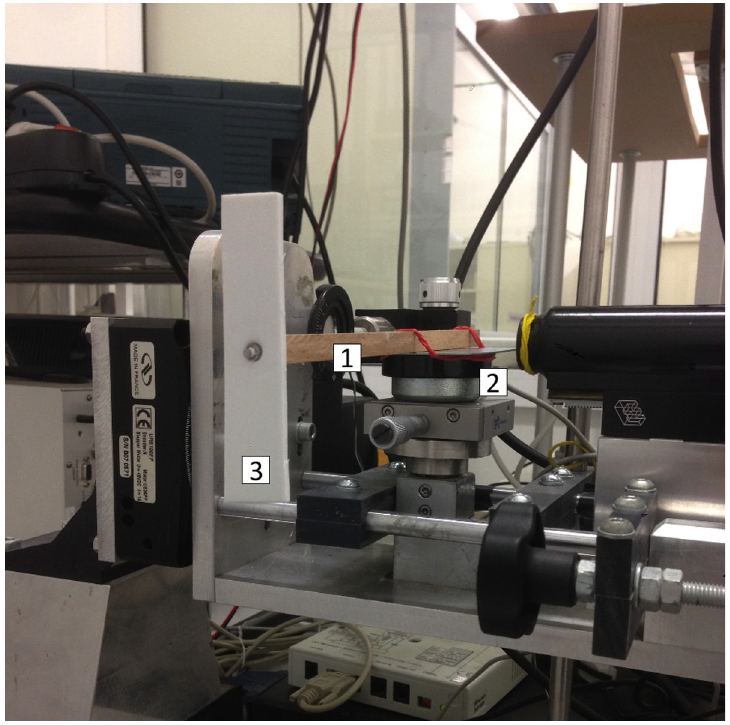
Fig 4. Experimental setup. The experimental setup of the system, with the notched stick (1) mounted on the loudspeaker (2) and endowed with a polyurethane propeller (3).